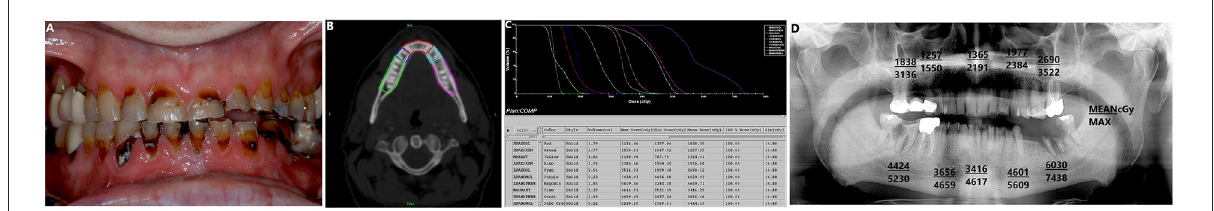
FIGURE2 (A) A 55-year-old- male patient, diagnosed with HPV positive T2N2M1 squamous cell carcinoma of left palatine tonsil and treated with concurrent chemoradiation (6996cGy in 33 fractions), reported to our Dental Service for opinion and management of grossly decayed left mandibular posterior teeth. (B) CT slide with 5 different teeth regions contoured in the mandible. (C) Dose volume histogram depicting maximum and mean radiation dose to 10 different teeth region in the maxilla and mandible. (D) Mean and maximum dose to the different teeth regions are mapped on to the patient’s panoramic radiograph. Teeth-bearing regions with prescribed dose = above 5000Gy are considered at increased risk for ORN. For example, the ipsilateral mandibular left molar region had prescribed mean and maximum doses of 6030cGy